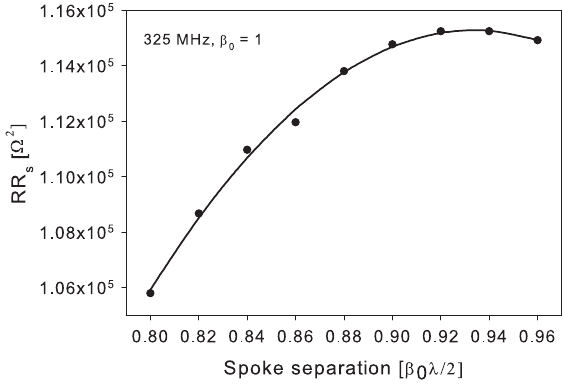
FIG. 25. Dependence of RR s on spoke